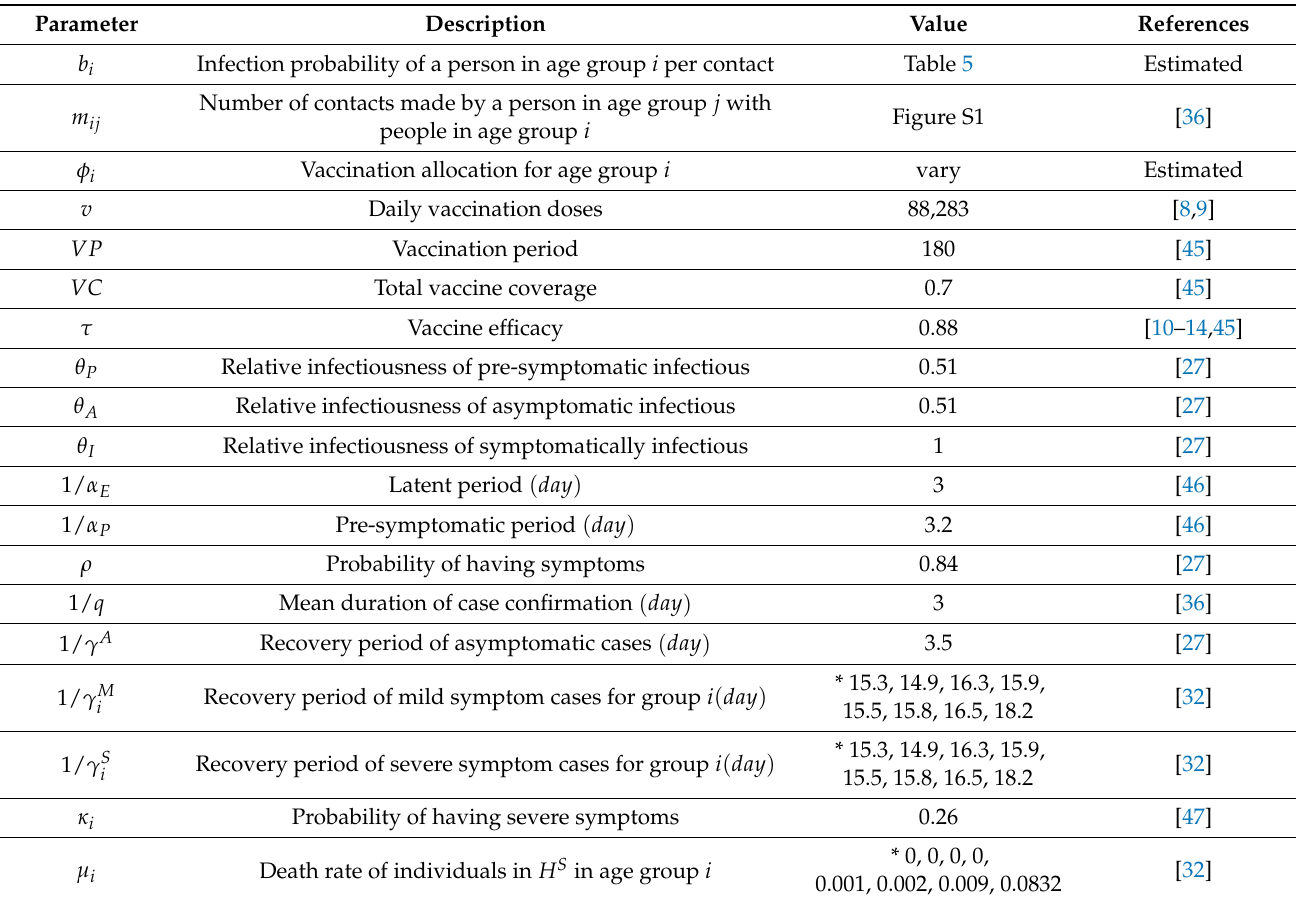
Table 4. Descriptions of parameters.